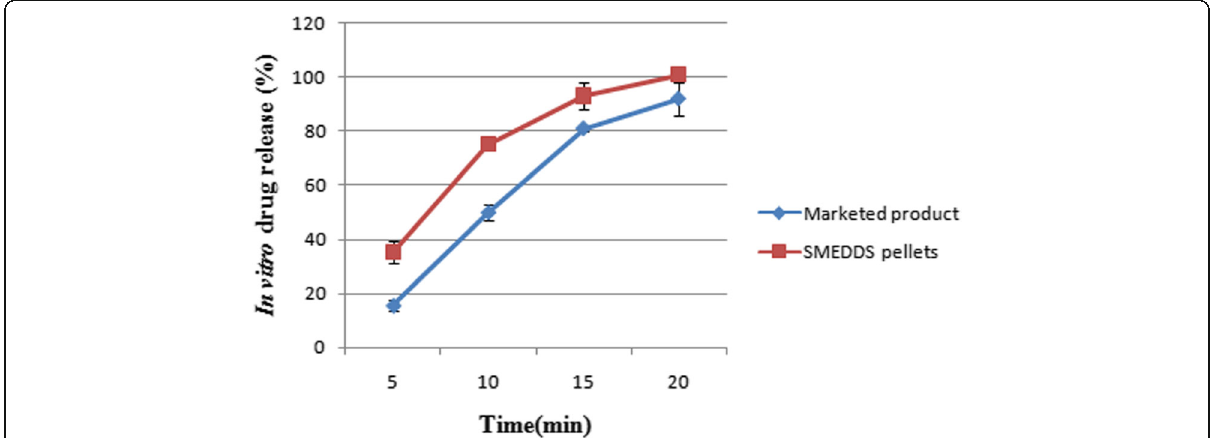
Fig. 5 Comparison of drug release of SMEDDS pellet with the marketed